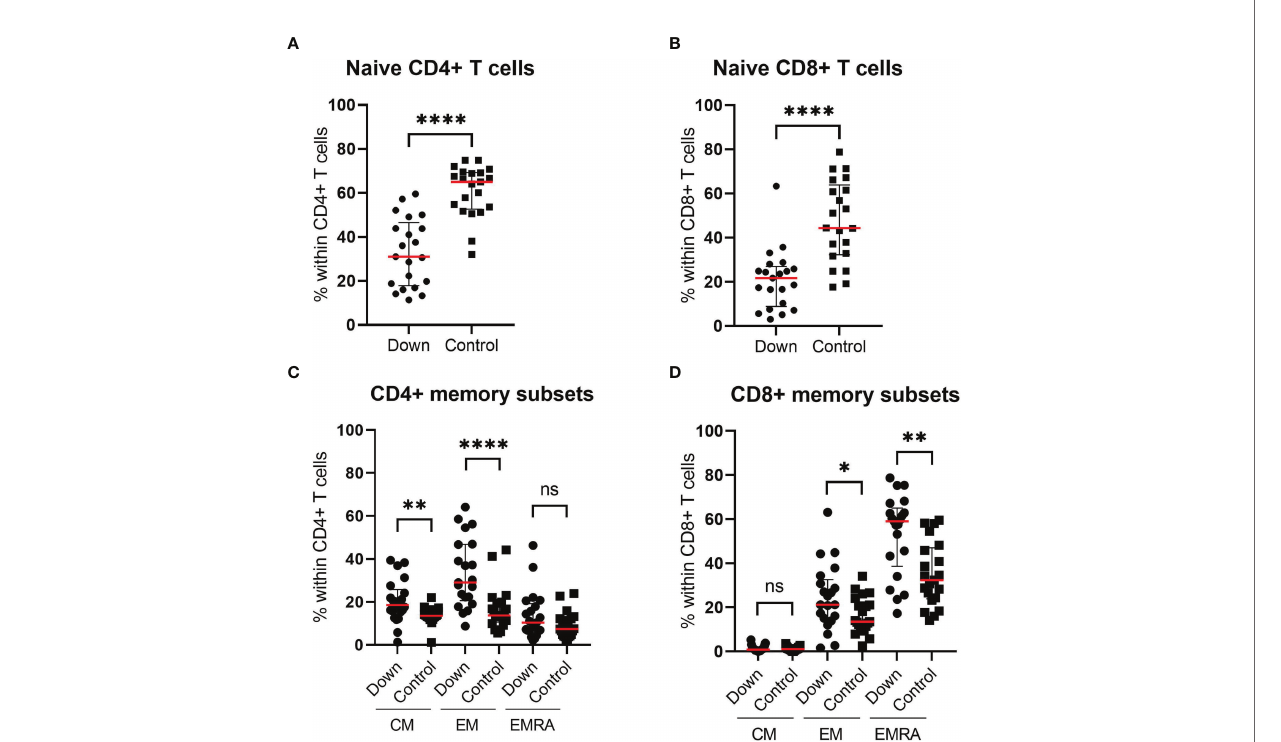
FIGURE 3 | Immunophenotyping of the T cell compartment of 21 children with Down syndrome and 21 healthy age-matched controls. Children with Down syndrome have signi fi cantly lower naive CD4+ T cells (CD4+CD45RA+CCR7+) (A) and lower naive CD8+ T cells (CD8+CD45RA+CCR7+) (B) compared to healthy controls. (C) Within the CD4+ T cells, the proportion of CM and EM cells is increased in children with Down syndrome. (D) For CD8+ T cell distribution, there is no signi fi cant difference in the percentage CM cells, however, children with Down syndrome have increased EM and EMRA. Median and interquartile ranges are indicated. *p <0.05; **p < 0.01; ****p < 0.0001; ns p >